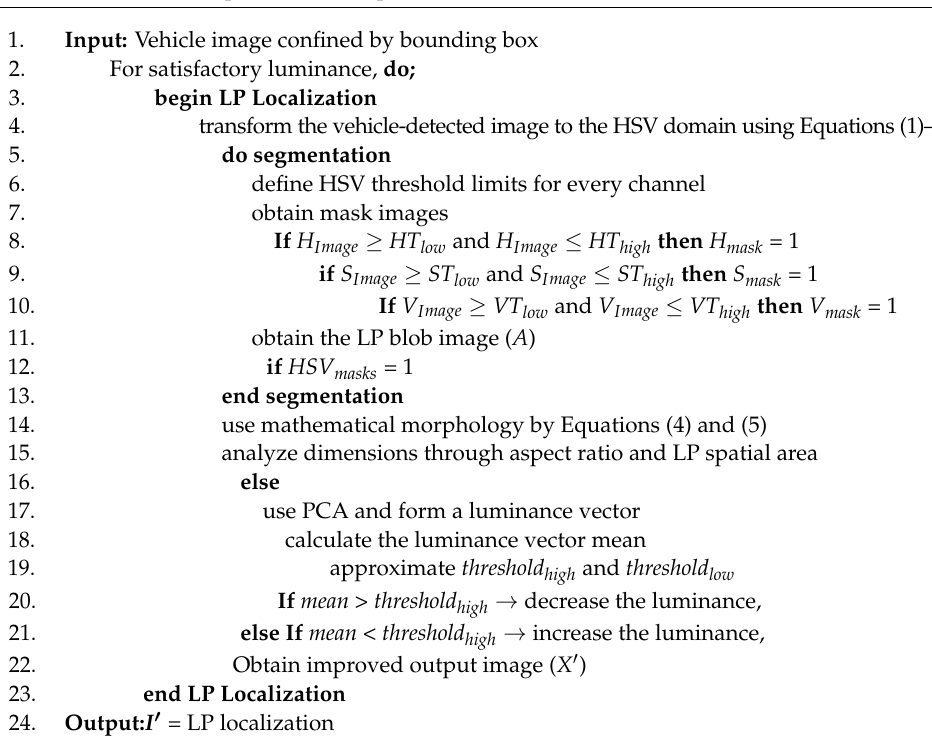
Algorithm 2: License plate detection